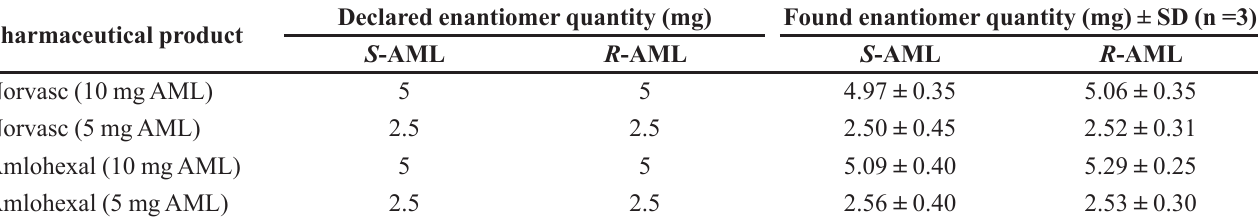
TABLE V - Determination of AML enantiomers from pharmaceutical preparations Pharmaceutical